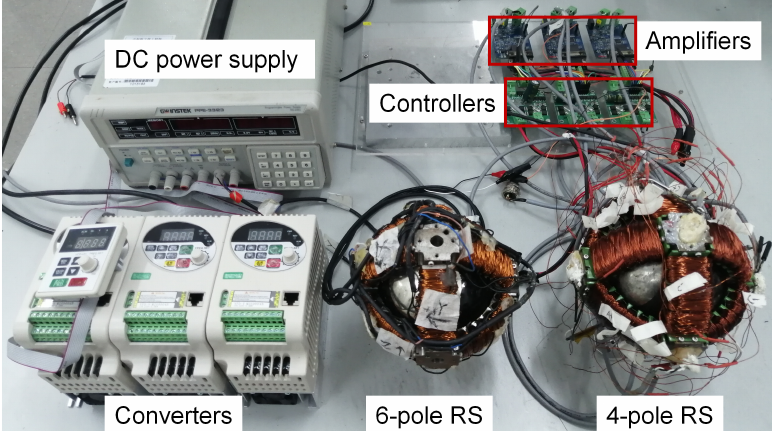
Figure 11. Experimental setup for driving the 4-pole reaction sphere and 6-pole reaction sphere under magnetic levitation.